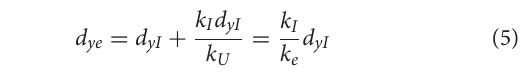
From the static equilibrium at the yielding point, the